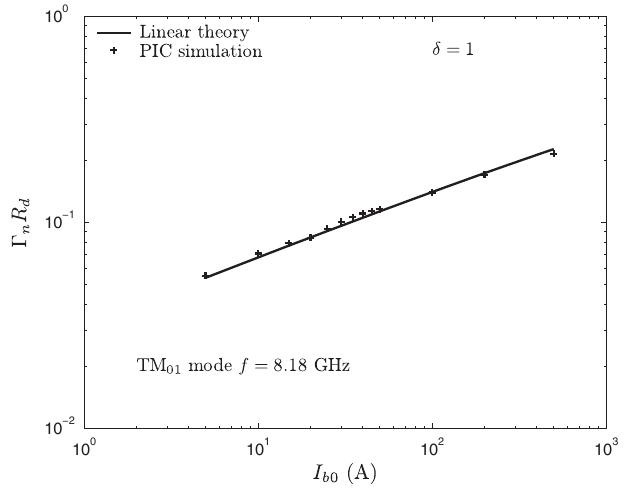
FIG. 17. Normalized growth rates for TM 01 mode as a function of beam current for (cid:1) ¼ 1 . Spatial growth rate is proportional to I 1 = 3 . b